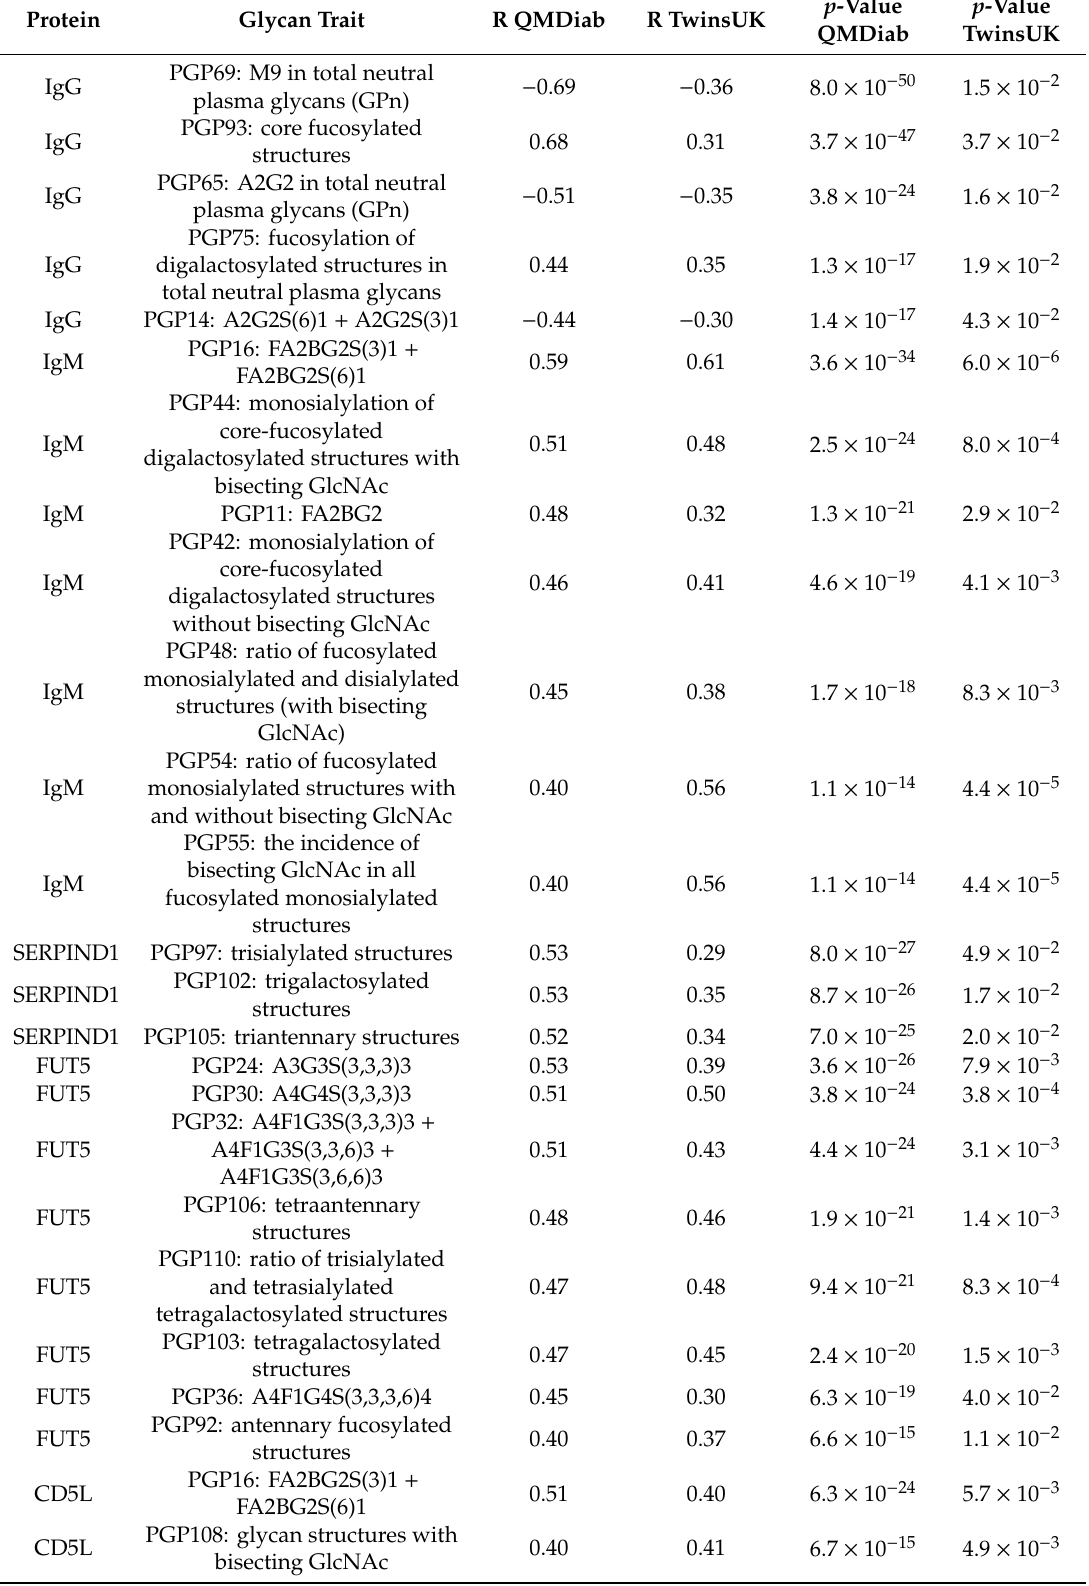
Table 1. Selected protein–glycan associations. Pearson correlations between inverse-normal scaled traits and corresponding p -values are